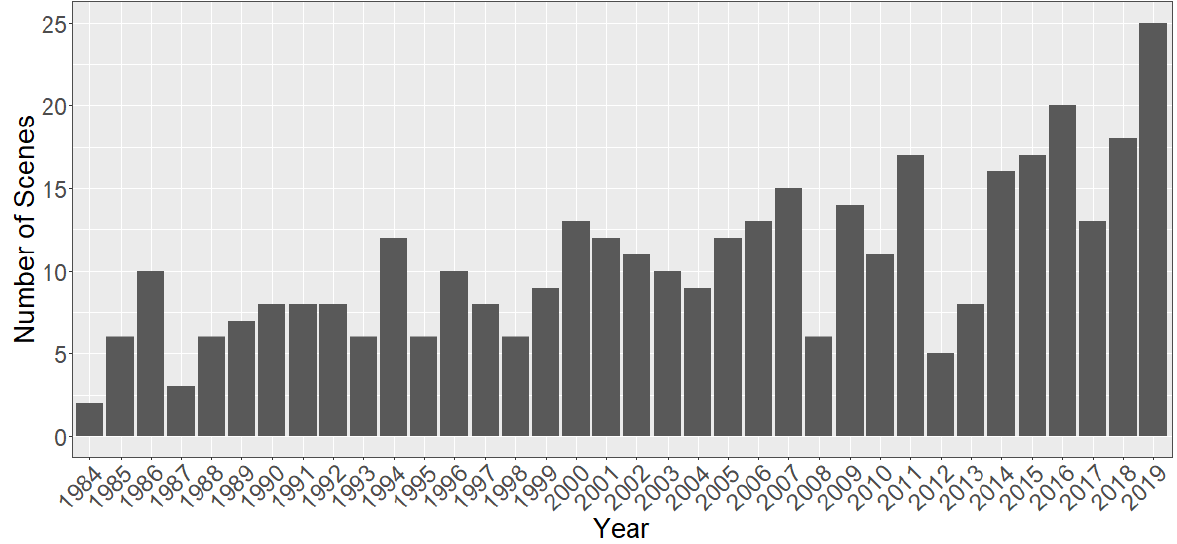
Figure 10. Frequency of combined Landsat data per year from the sensors TM, ETM+ and OLI of the Steigerwald. The remote sensing imagery was masked from clouds, cloud shadows and snow. An overall increase in data frequency can be observed.